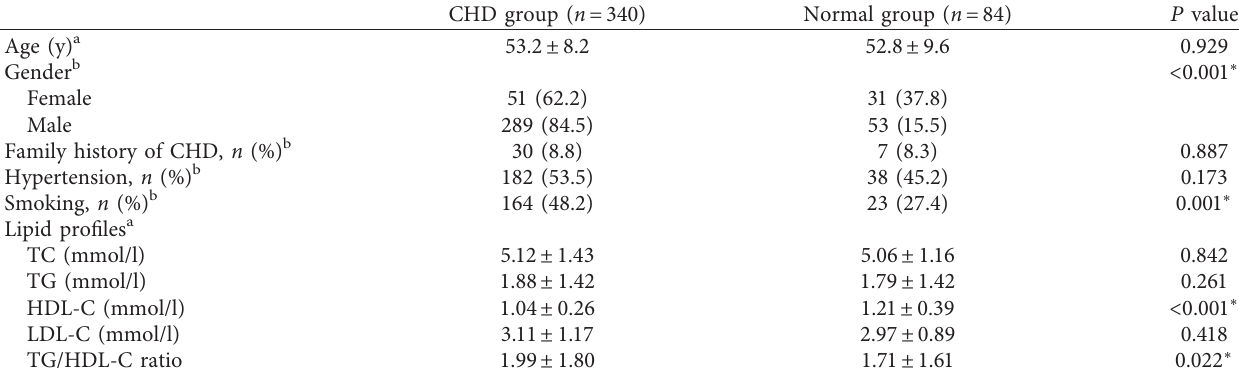
Table 1: Characteristics of patients without diabetes in the CHD group and normal group.